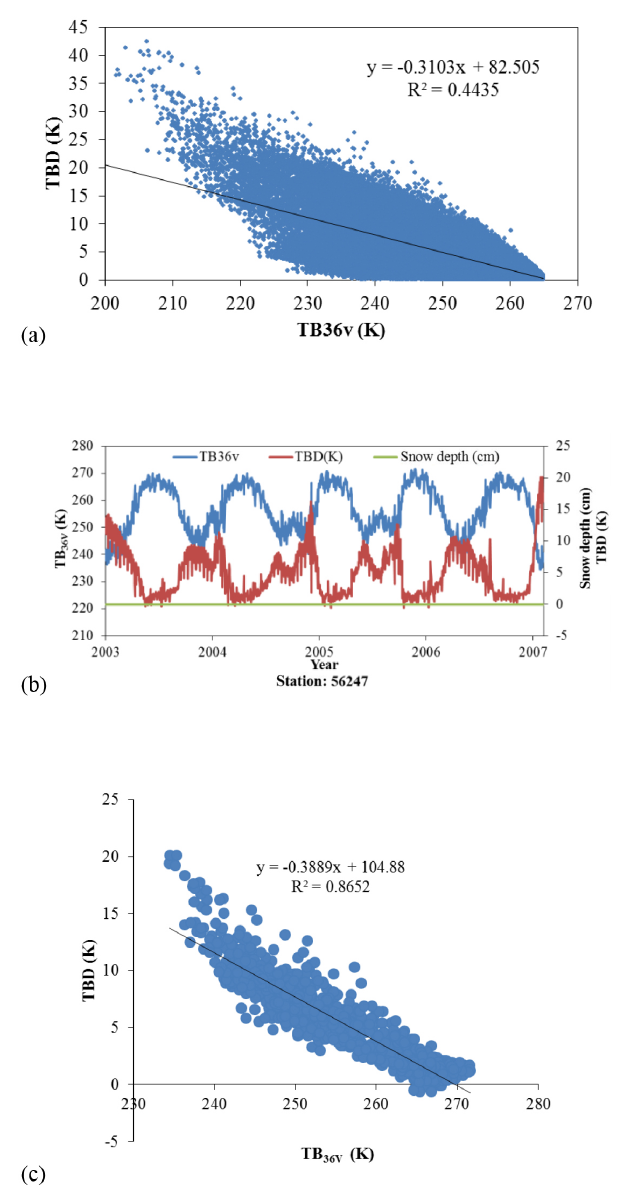
Figure 8. Relationship between TBD and TB 36V at all stations (a) and Batang station (ID: 56247) (c) ; the temporal variation of TB 36V , TBD and snow depth observed at Batang station (b) .